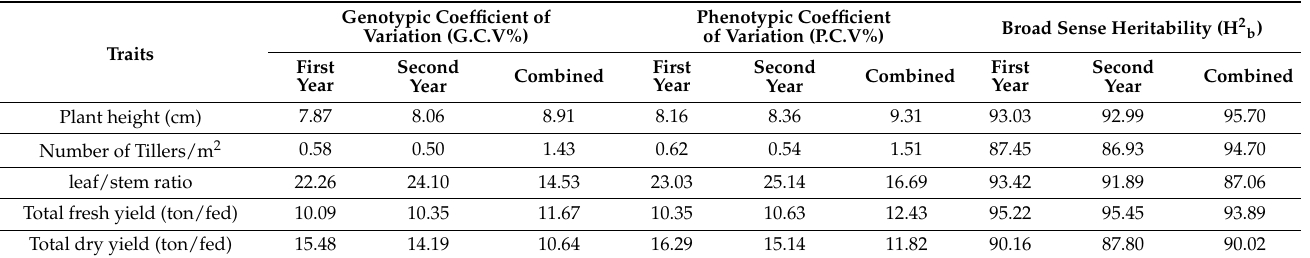
Table 5. The percentage of variability parameters for agronomic studied traits in twenty-one alfalfa genotypes in the two seasons and combined across the two